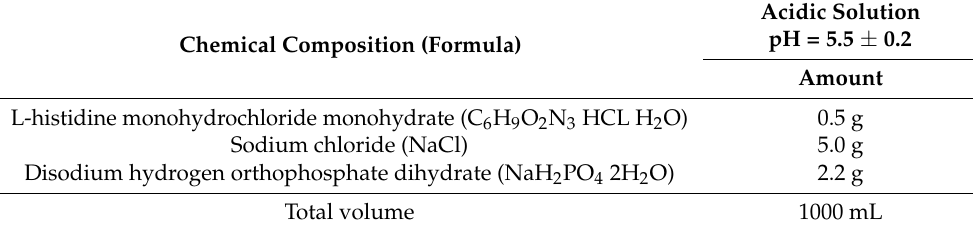
Chemical Composition (Formula)